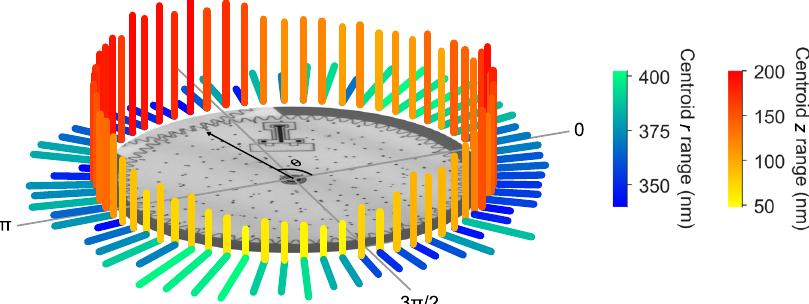
Fig. 7 Play analysis. Polar plot showing the range of motion of the constellation centroid in the radial direction and the axial direction at all 64 nominal orientations of the load gear. The bar length scales nonlinearly in the plane for clarity. The inset micrograph and black arrow show the direction of the coupling between the load gear and ring